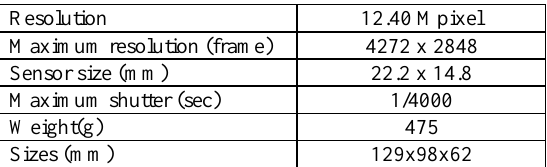
Table 1 Canon EOS 450D Technical Specifications